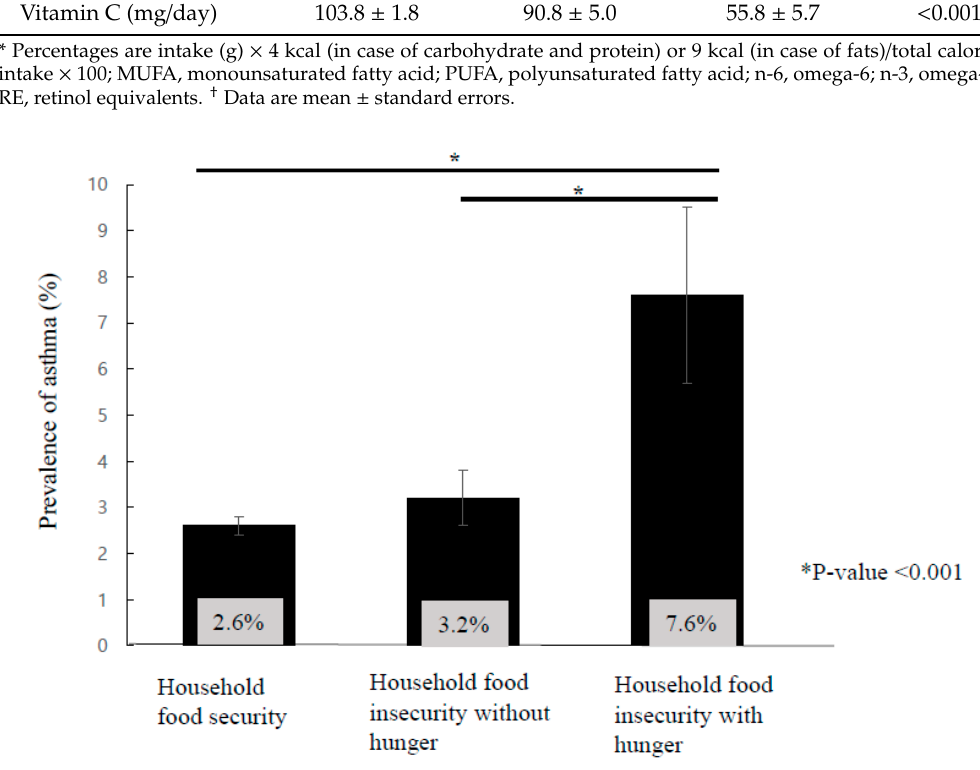
Figure 1. Prevalence of asthma according to household food insecurity. * p values were calculated using the general linear model with Bonferroni correction. Table 4. Odds ratios (ORs) (95% CIs) for asthma according to household food security status in Korean